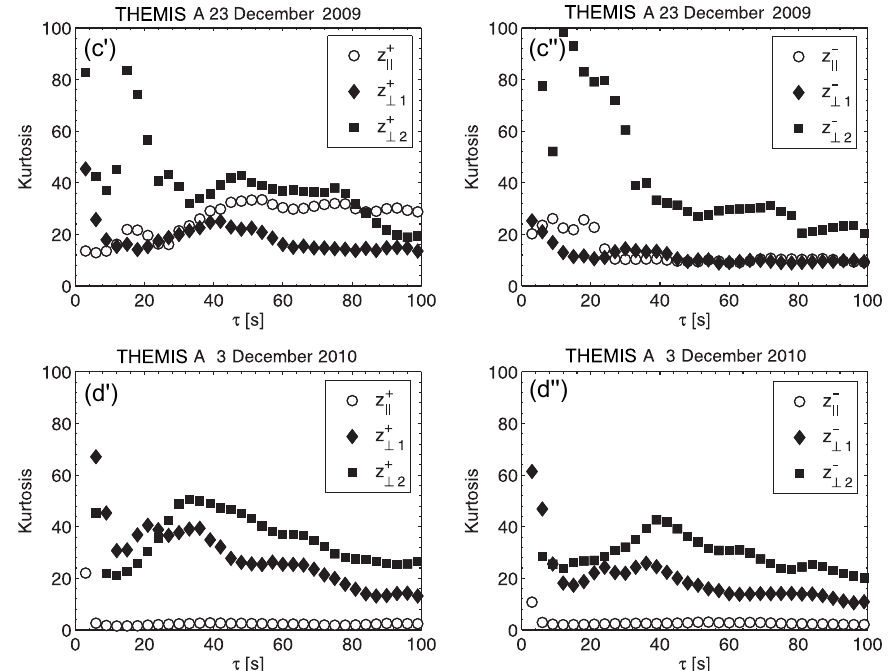
Figure 15. Kurtosis for the increments of the parallel (white circles) and perpendicular (black diamonds and squares) components of the Elsässer variables, δ z + (c’, d’) and δ z − (c”, d”), as a function of timescale τ near the magnetopause (cases (c) and (d) in Table